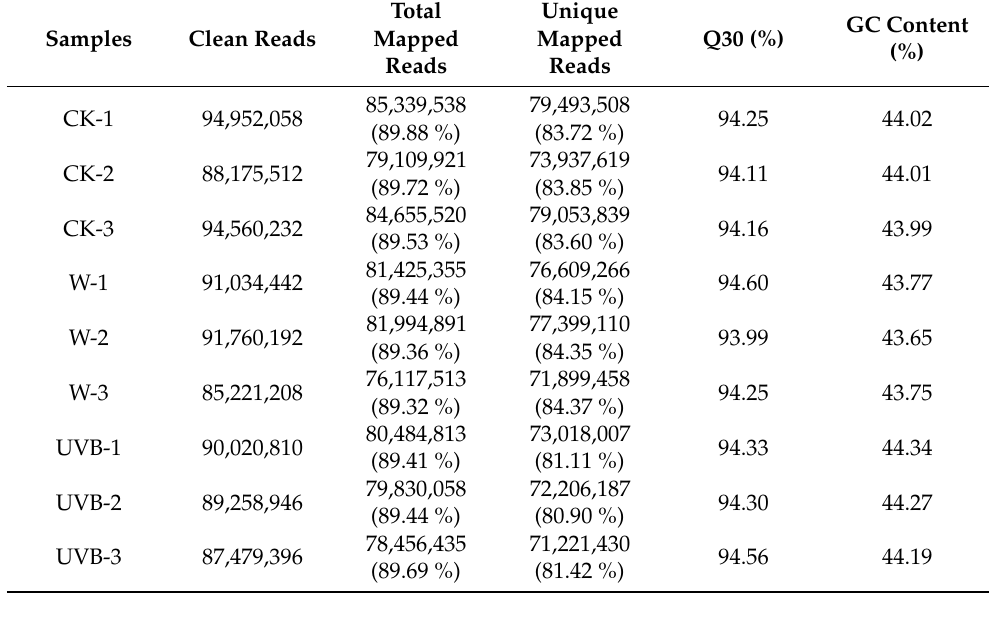
Table 2. Summary of RNA-seq data of whole (CK), wounded (W) and UV-B–treated (UV-B) carrots after storage at 15 ◦ C for 1 h.